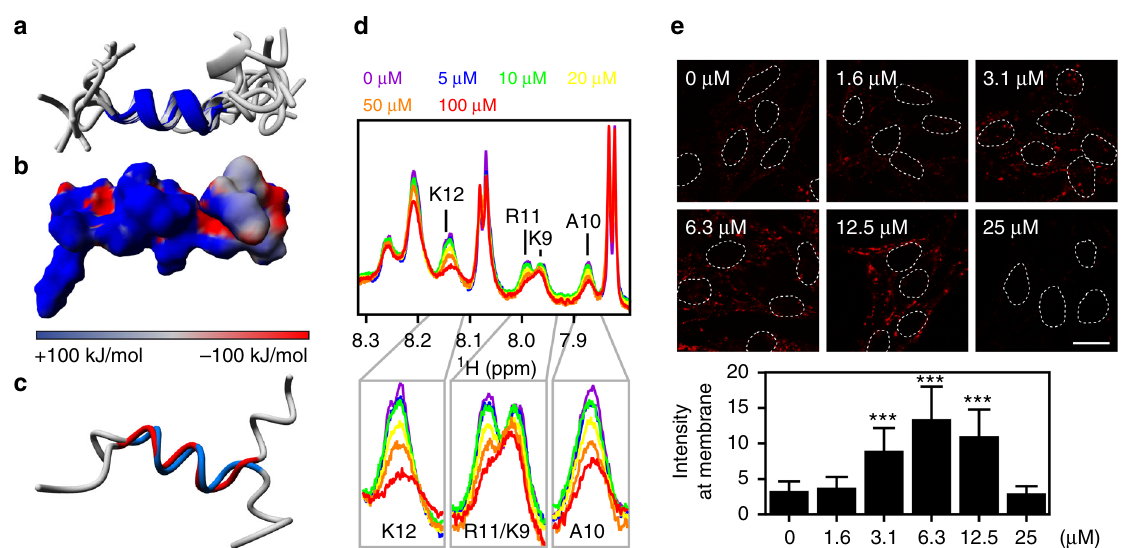
Fig. 5 Molecular tweezers inhibit the translocation of SpHtp3. a Superimposition of the 10 lowest-energy NMR-based structures of the C-terminal peptide of SpHtp3 with the central helix (P204-K211) highlighted. b Electrostatic surface presentation of the C-terminal peptide of SpHtp3. Positive, neutral and negative charges are displayed in blue, grey and red, respectively. c Superimposition of the NMR-based structures of the C-terminal peptide wt (blue) and the double mutant (K208A/R210A, red) of SpHtp3 with the central helix (P204-K211). d 1 H-1D NMR titration experiments of the SpHtp3 peptide with a stepwise increasing amount of tweezers as indicated. Decreasing signal intensities indicate an interaction of both. e Effect of molecular tweezers on the translocation of SpHtp3-mRFP into RTG-2 cells. With increasing tweezers ’ concentrations, the uptake and cell surface binding of SpHtp3 are interrupted. Nuclei are indicated by dashed lines. Error bars denote s.e.m. (cells: 50). *** p < 0.001 (one way ANOVA). Scale bar: 20 µ m ( n = 3)